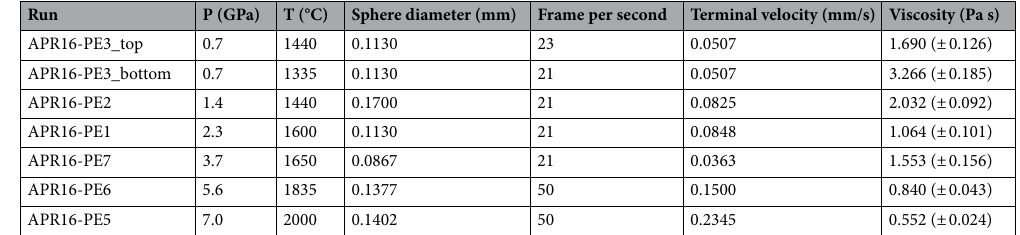
Table 1. Experimental conditions and result of viscosity measurements in this study.